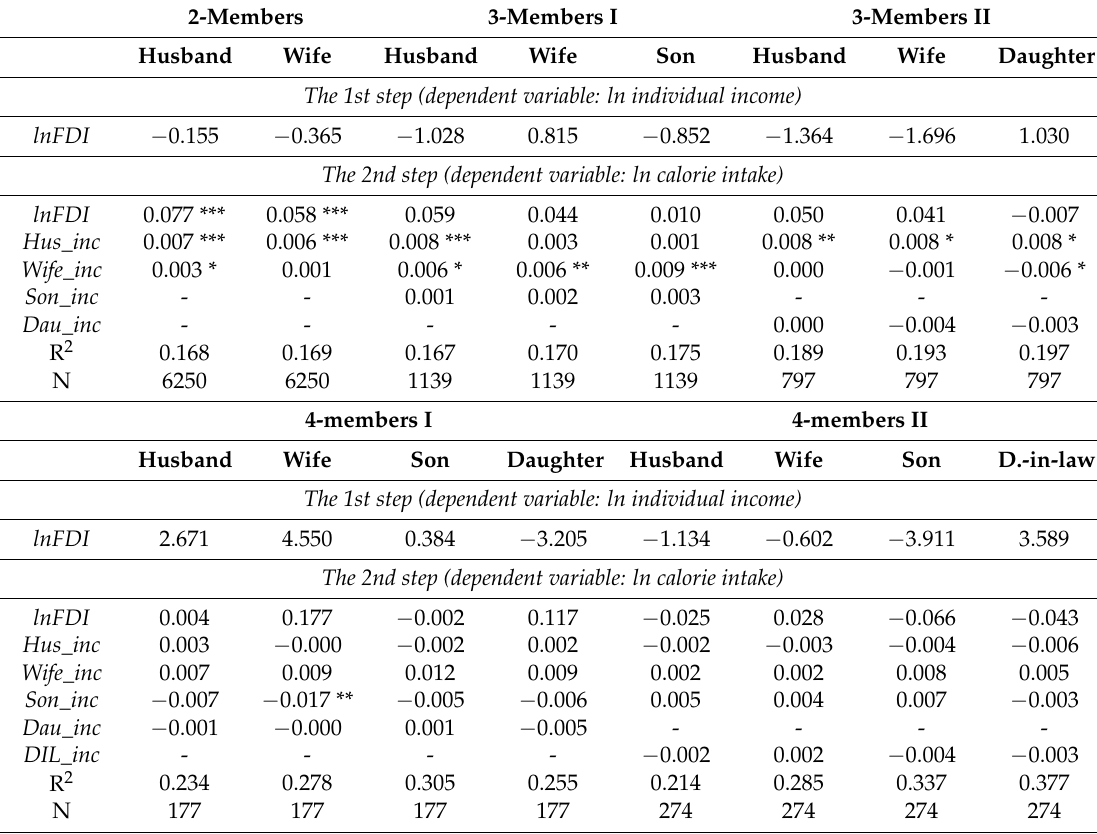
Table 6. Urban multiple adult members’ individual income